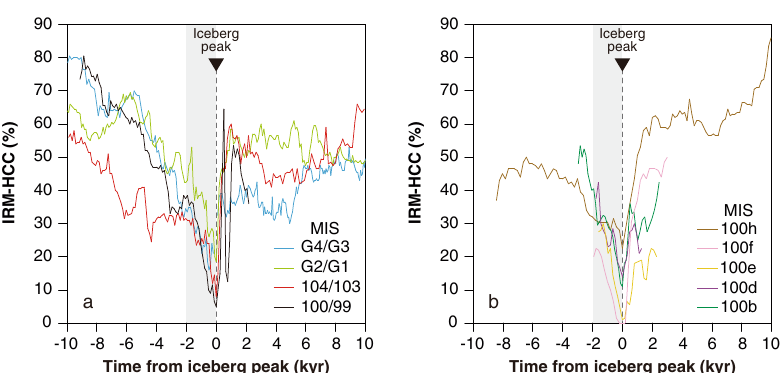
Fig. 3 Recovery of the ISOW after the in fl uence of large-scale iceberg melting. a Major deglaciations. b Stadial/interstadial transitions during the MIS 100